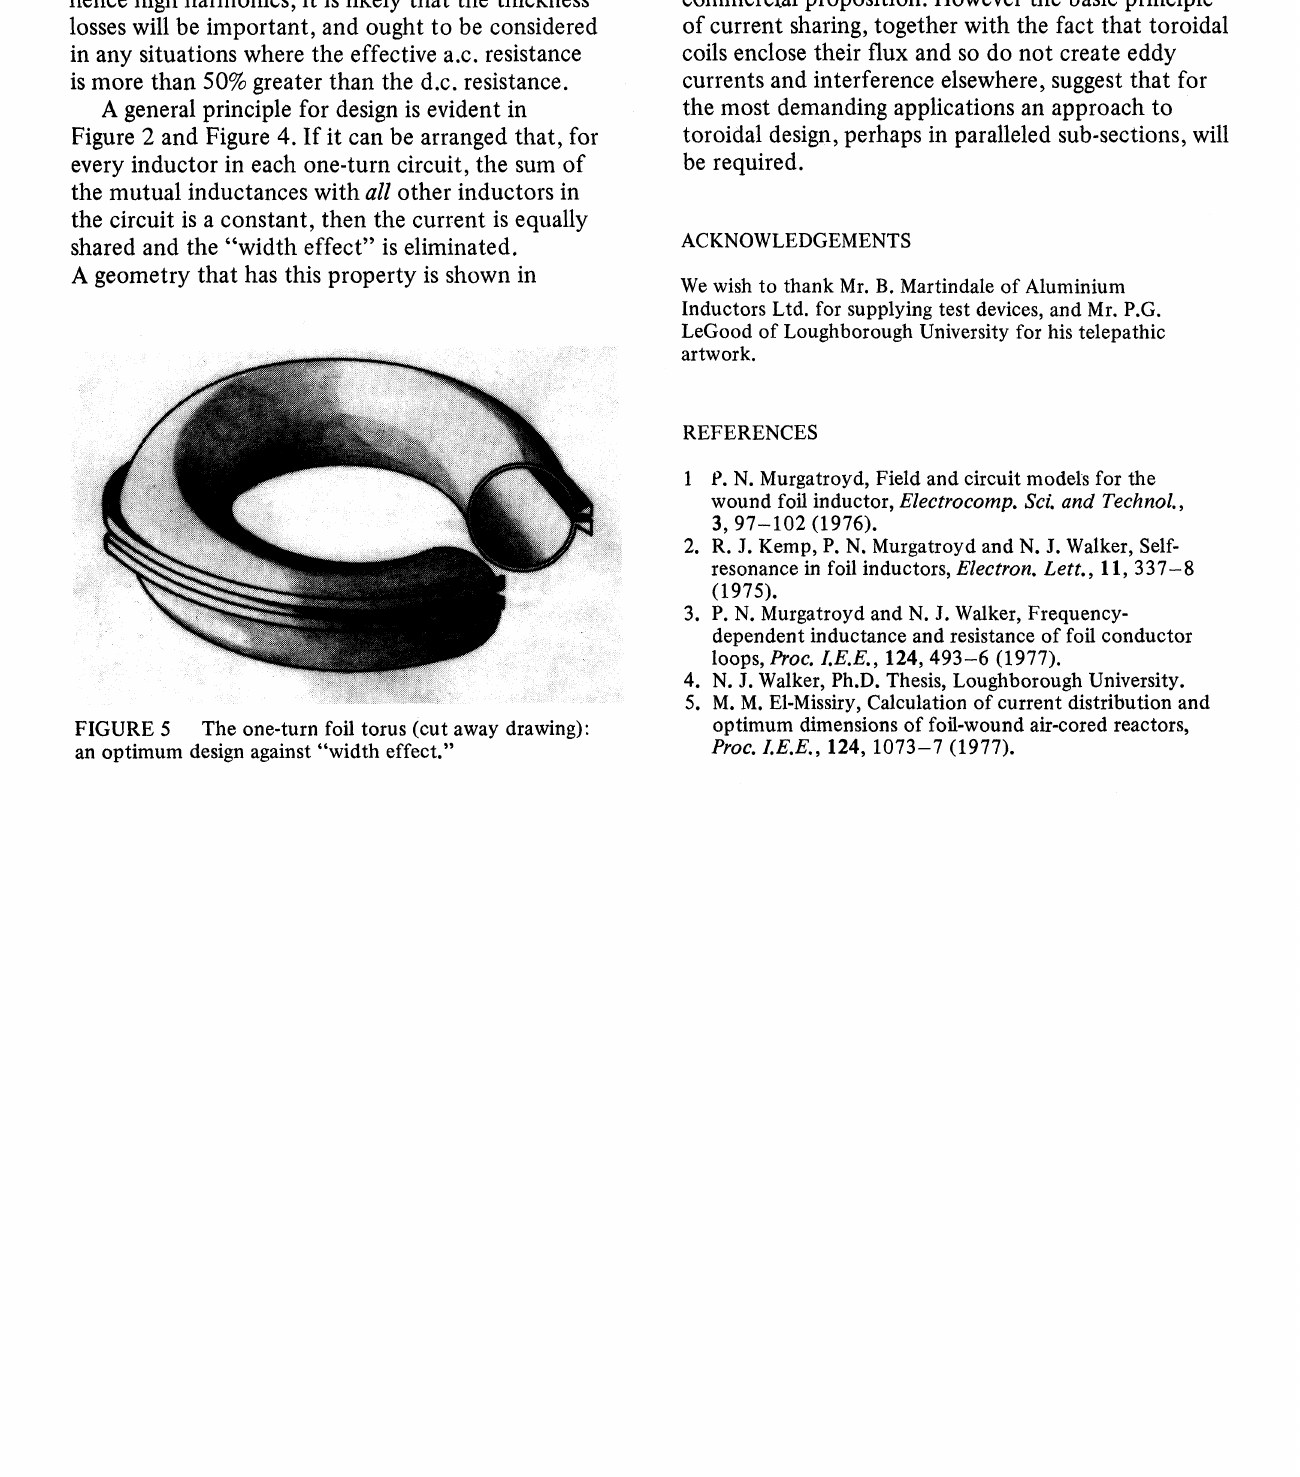
Figure 5. The torus is to be considered as complete, the break is only for purposes of